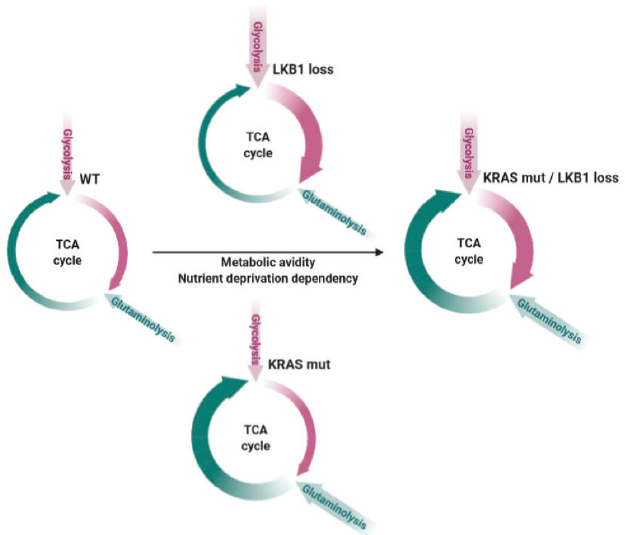
Figure 1. Schematic overview summarizing the enhanced metabolic avidity and nutrient deprivation sensitivity of KRAS and LKB1 co-mutated tumors compared to wild type (WT) or single mutated NSCLCs. Violet arrows refer to glycolysis and its exploitation in the tricarboxylic acid (TCA) cycle, while green arrows represent glutaminolysis and the TCA cycle fueled by this process. The thickness of the arrows shows the dependency of the two different processes according to the different backgrounds. The black arrow represents the increase in metabolic avidity and nutrient deprivation dependency according to the different genotypes. Adapted from [25].